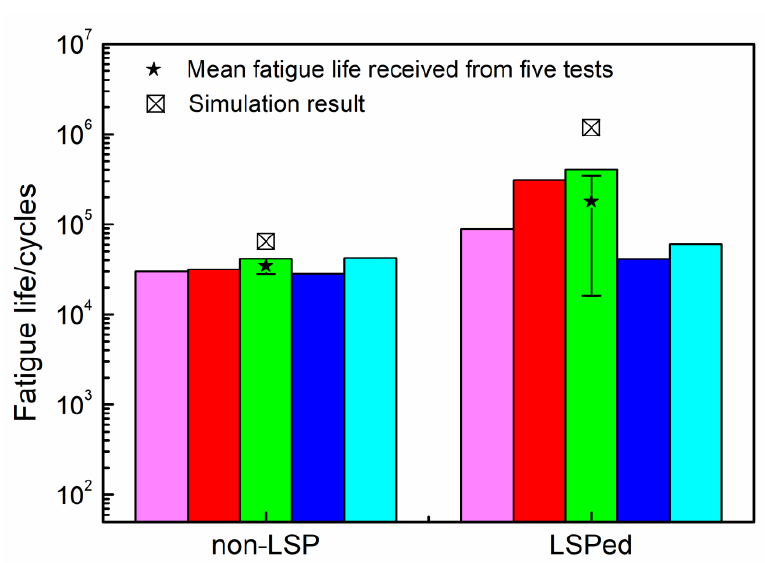
Figure 10. Simulated and measured fatigue lives of non-LSP and LSP-treated specimens induced by four-point bending.